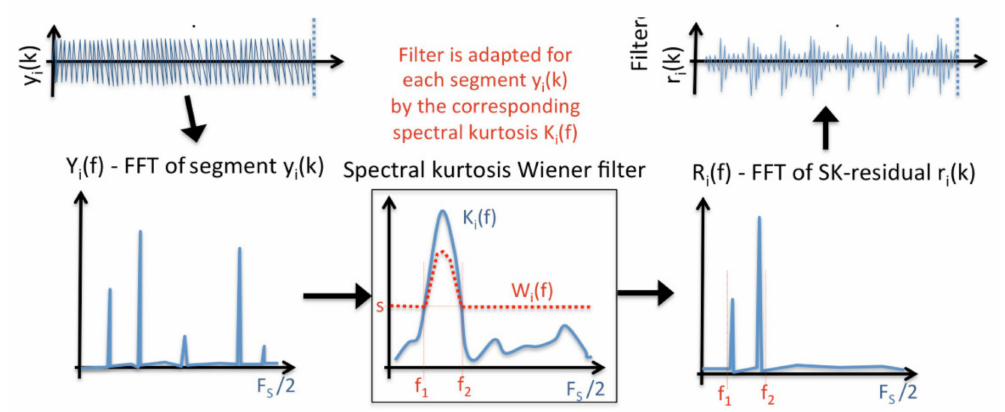
Figure 1. Pictorial representation of the SK derived Wiener filter with threshold ‘S’